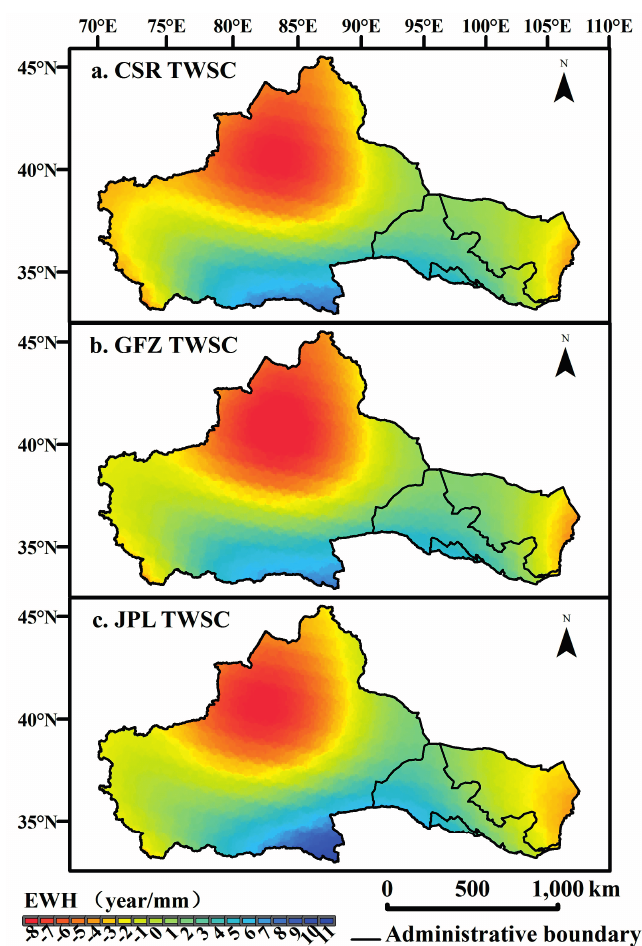
Figure 13. Spatial distributions of TWSC trend estimated from ( a ) CSR; (b ) GFZ; and ( c ) JPL GRACE products.